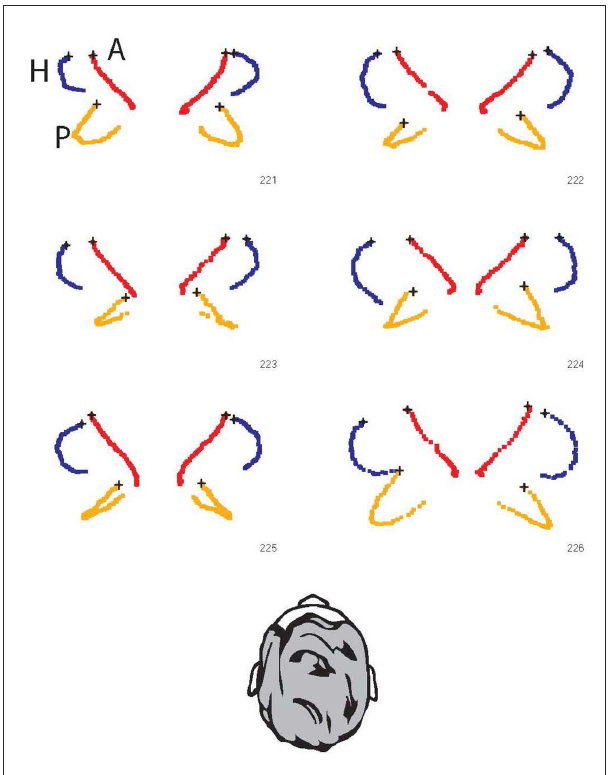
FIGURE7 The projection of all six semicircular canals onto the horizontal stimulus plane for six individual skulls. The points are the raw data of points along the bony semicircular canals of six skulls [data replotted from (6) with permission]. Blue: lateral canals; Red: anterior canals; Orange: posterior canals. In all cases, the ampulla is indicated by the black x. The response of the canal to rotation on the horizontal plane can be assessed visually by the area encompassed by the projection of each canal. So in each case the horizontal canals have the largest projected area, and in each case the anterior canals have minimal projected area and so minimal stimulation. However, it is the posterior canals which show large projected areas (e.g., 221 and 226) with large differences between individuals—e.g., in 223 and 225 both posterior canals have minimal projection into the horizontal plane, but in 221 and 226 the orientation of the posterior canal in the head is so large that it has a sizeable projection into the horizontal plane, and so will be stimulated during a horizontal head turn (see also Supplementary Figure 2). These projections correspond to those in Figure 5C of (5) and may appear small, but recall the angular acceleration in vHIT testing is very large (of the order of 2,000–3,000 deg/s/s) so that even a small areal